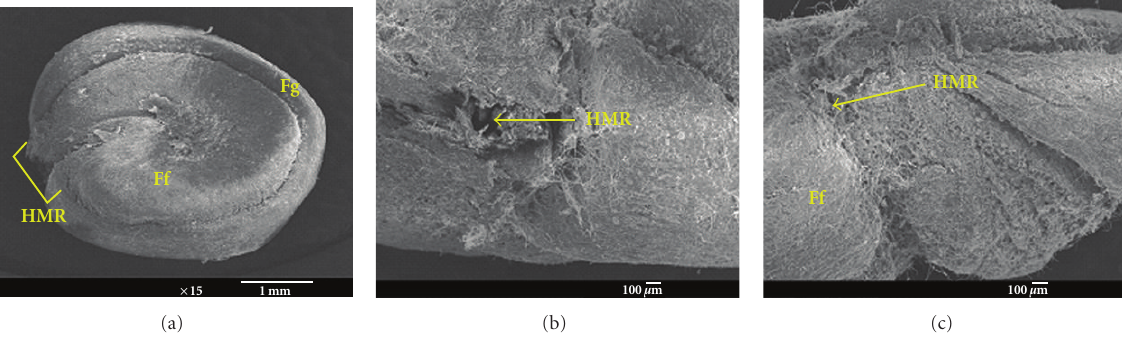
Figure 5: Micrographs of Opuntia tomentosa seeds exhumed after 5 mo of burial: (a) whole seed showing a slight separation of the funicular girdle; (b) deep degradation in the hilum-micropiliar zone and in the surface layers of a seed buried at the open site; (c) deep degradation in the hilum-micropiliar zone and in the surface layers of a seed buried at the closed site. Ff: funicular flanks, Fg: funicular girdle, HMR: hilum- micropylar region.